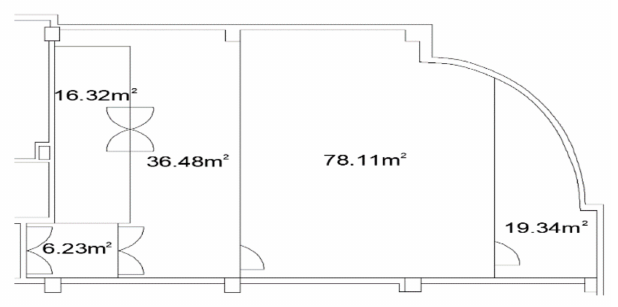
Figure 1. Analysis model for the computer